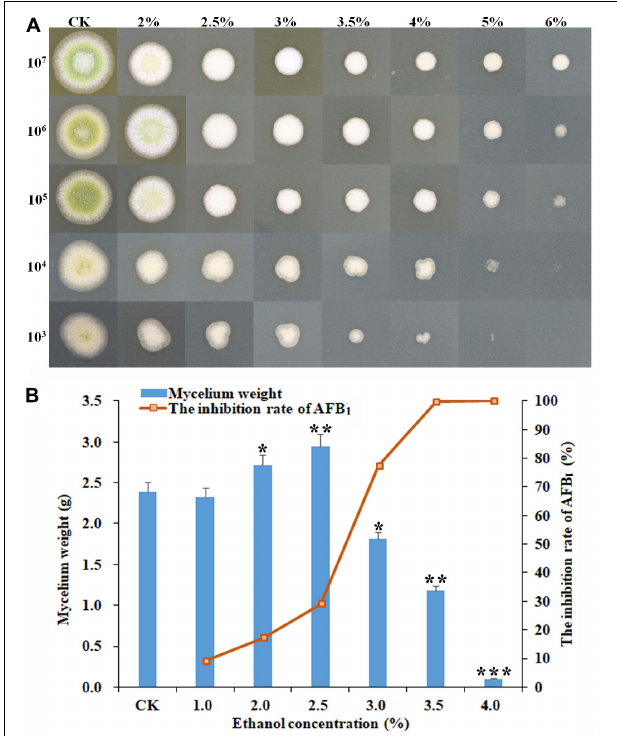
FIGURE 1 | Effect of ethanol on the mycelial growth and AFB 1 production of A. flavus NRRL3357. (A) The inhibitory effect of ethanol at different concentrations (from 0 to 6%) on mycelial colonies on PDA plates by inoculating the serial dilutions of A. flavus conidia (from 10 7 to 10 3 ) at 48 h post-treatment. (B) The mycelia biomass of A. flavus and the inhibition rate of AFB 1 in YES broth at 120 h post-treatment. ∗ p < 0.05; ∗∗ p < 0.01; ∗∗∗ p <